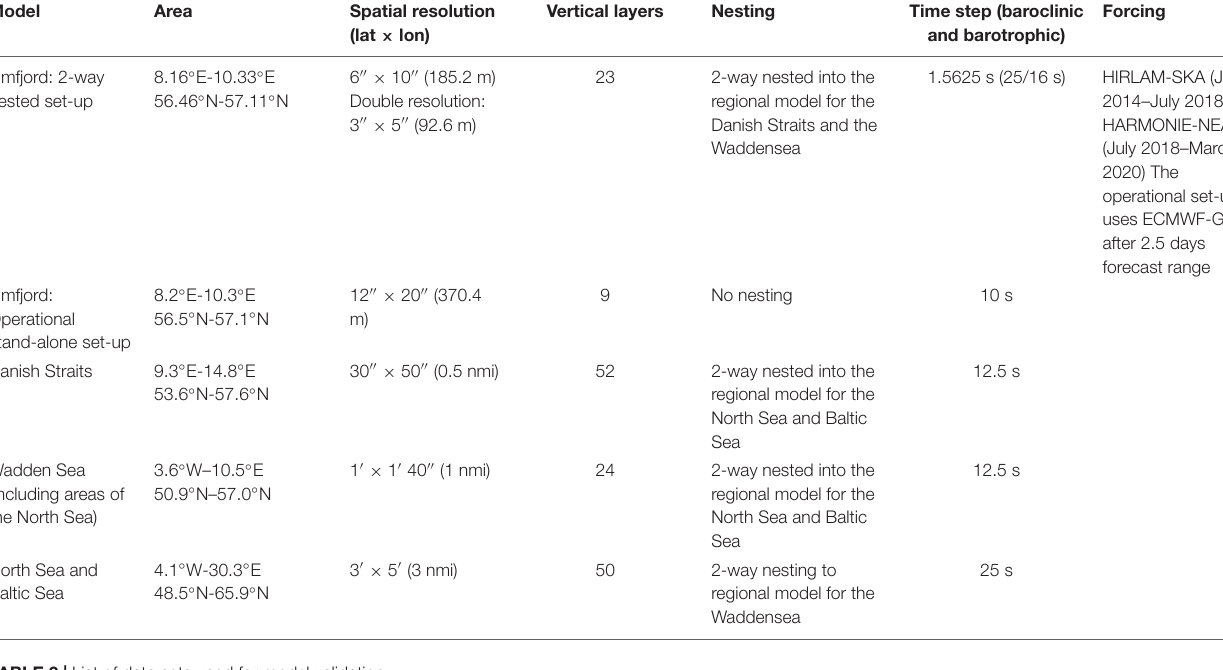
TABLE 1 | Overview over the HBM model setup.